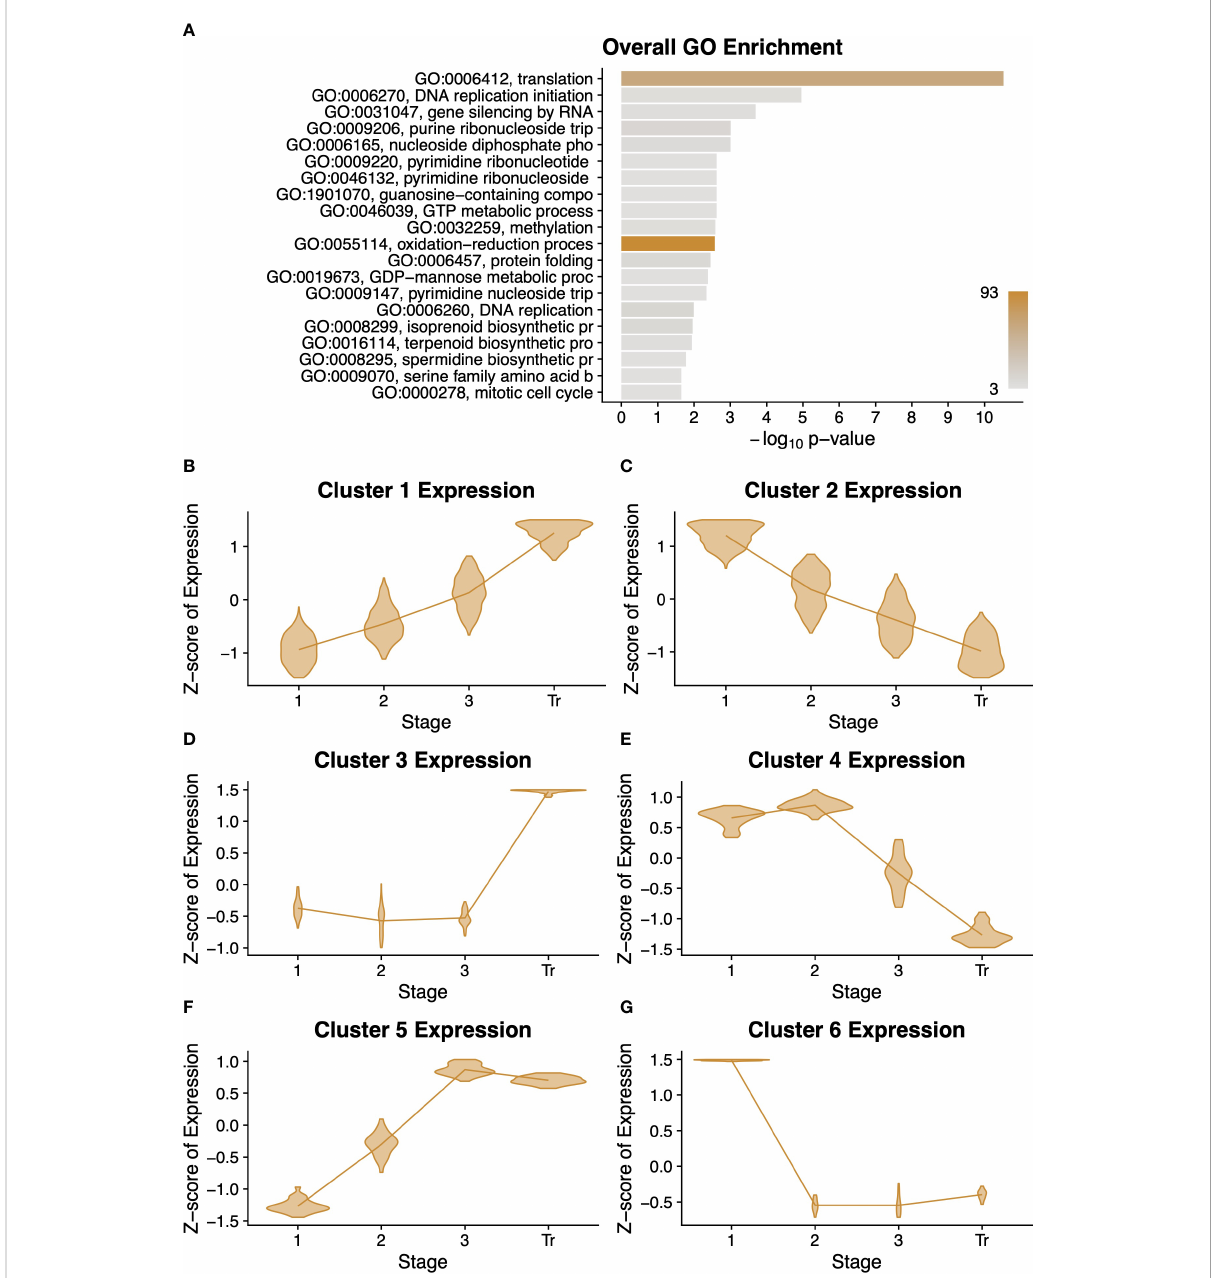
FIGURE 3 Summary of desert tobacco differentially expressed genes. A gene ontology (GO) term enrichment analysis (A) performed on all 1351 differentially expressed genes. All clusters of differentially expressed genes are described with violin plots of normalised expression at each stage of development (B – G) comprising. Stages of fruit development in the axis of (B – G) are numbered sequentially followed by “ Tr ” for transition to mature